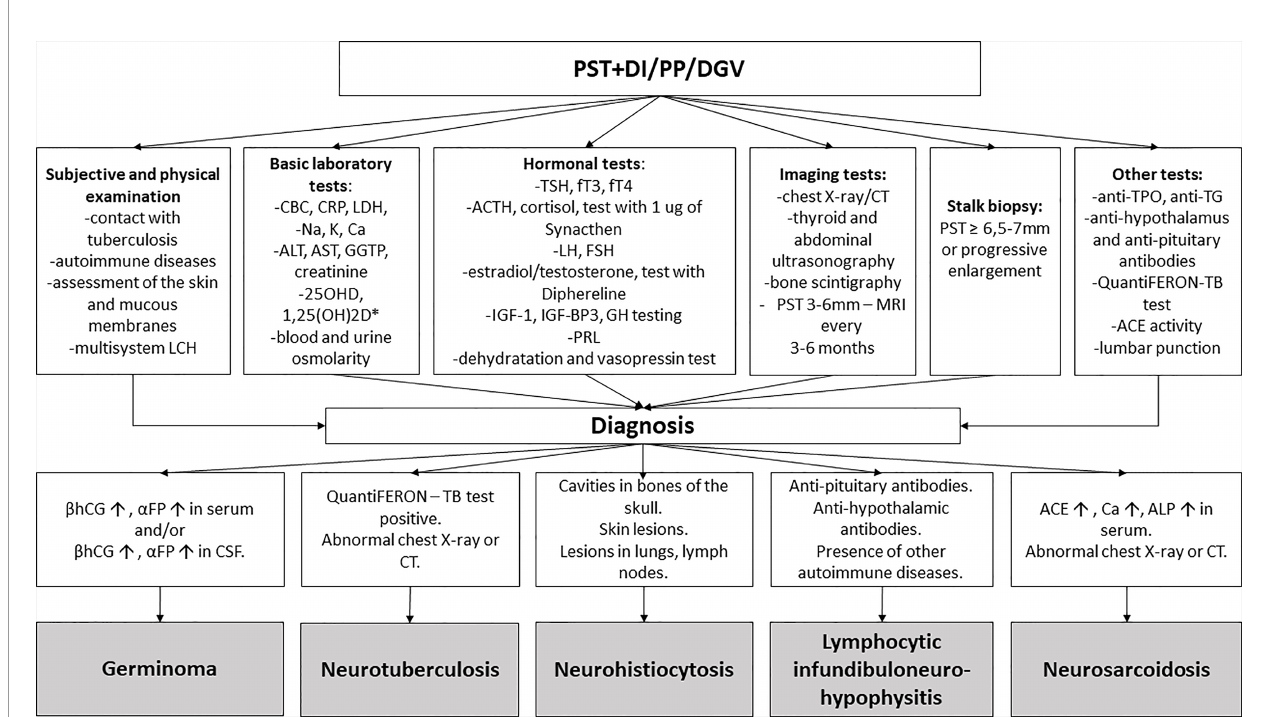
FIGURE 7 | The diagnostic process of pituitary stalk thickening. PST, pituitary stalk thickening; DI, diabetes insipidus; PP, precocious puberty; DGV, decreased growth velocity; LCH, Langerhans cell histiocytosis; CBC, complete blood count; CRP, c-reactive protein; LDH lactate dehydrogenase; ALAT, alanine transaminase; ASPAT, aspartate transaminase; GGTP, gamma-glutamyl transpeptidase; 1,250HD, 1,25-dihydroxyvitamin D; 250HD, 25-hydroxycholecalciferol; Ca, calcium; Na, sodium; K, potassium; TSH, thyroid-stimulating hormone; FT3, free triiodothyronine; FT4, free thyroxine; ACTH, adrenocorticotropic hormone; LH, luteinizing hormone; FSH, follicle-stimulating hormone; IGF-1, insulin-like growth factor 1; IGF-BP3, insulin-like growth factor-binding protein 3; GH, growth hormone; PRL, prolactin, CT- computed tomography; anti-TPO, thyroid peroxidase antibody; anti-TG, antithyroglobulin antibody; ACE, angiotensin-converting enzyme. TB, tuberculosis, b hCG- beta subunits of human chorionic gonadotropin; a FP- alpha-fetoprotein; ALP, alkaline phosphatase; MRI, magnetic resonance imaging; CSF, cerebrospinal fl uid. * in case of suspicion of